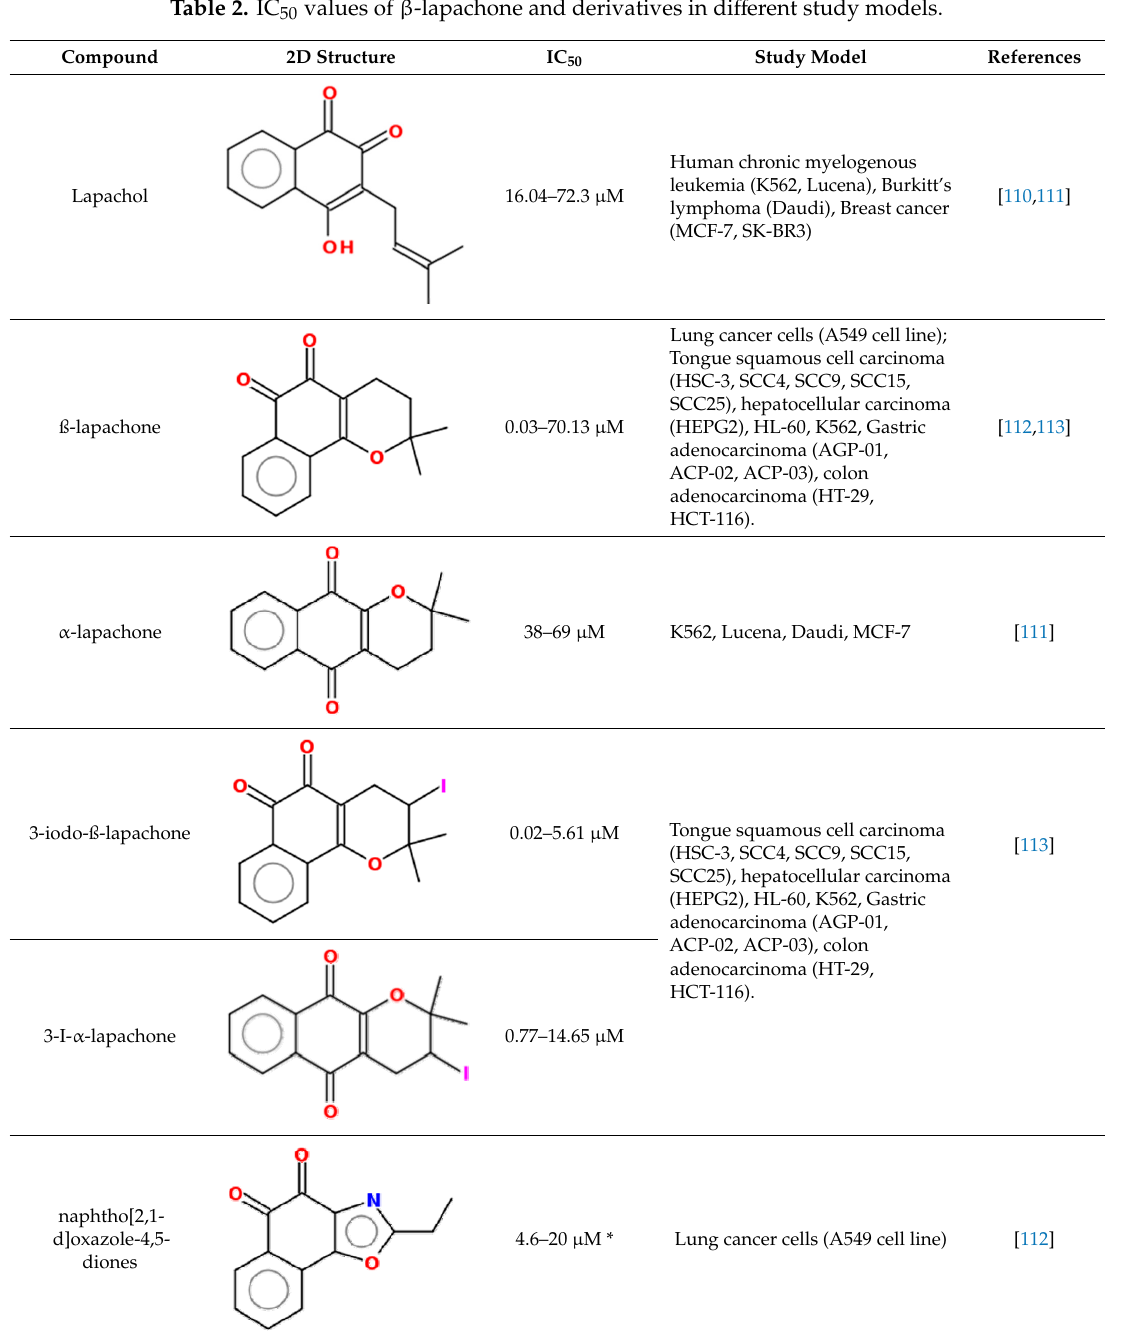
Table 2. IC 50 values of β -lapachone and derivatives in different study models.